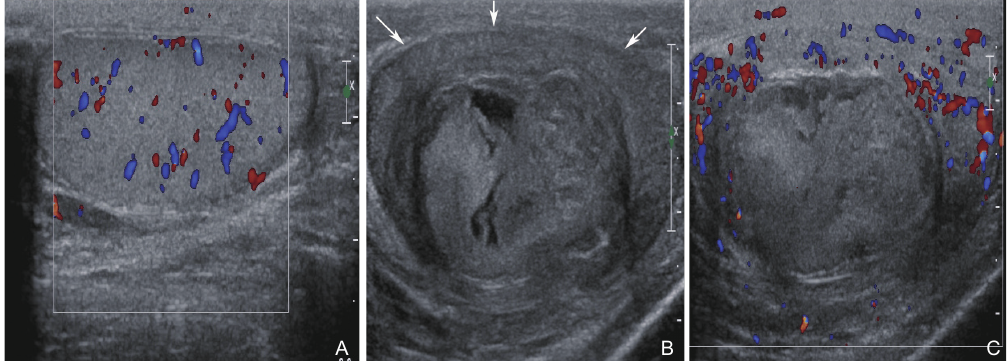
Figure 4 A fifty-nine-year-old man had left-sided epididymitis-orchitis combination with testicular necrosis which was confirmed by surgery (orchiectomy). Histopathologic results also confirmed ultrasound and surgical findings. (A) CDU imaging in the longitudinal plane shows normal vascularization of the right testis; (B) grayscale ultrasound imaging in the longitudinal plane shows hypoechogenicity and heterogeneous echogenicity in the left testis. The image also shows diffuse enlarged epididymis (arrows); (C) CDU imaging in the longitudinal plane shows ABF in the left testis. The image also shows hyperemia in the epididymis.